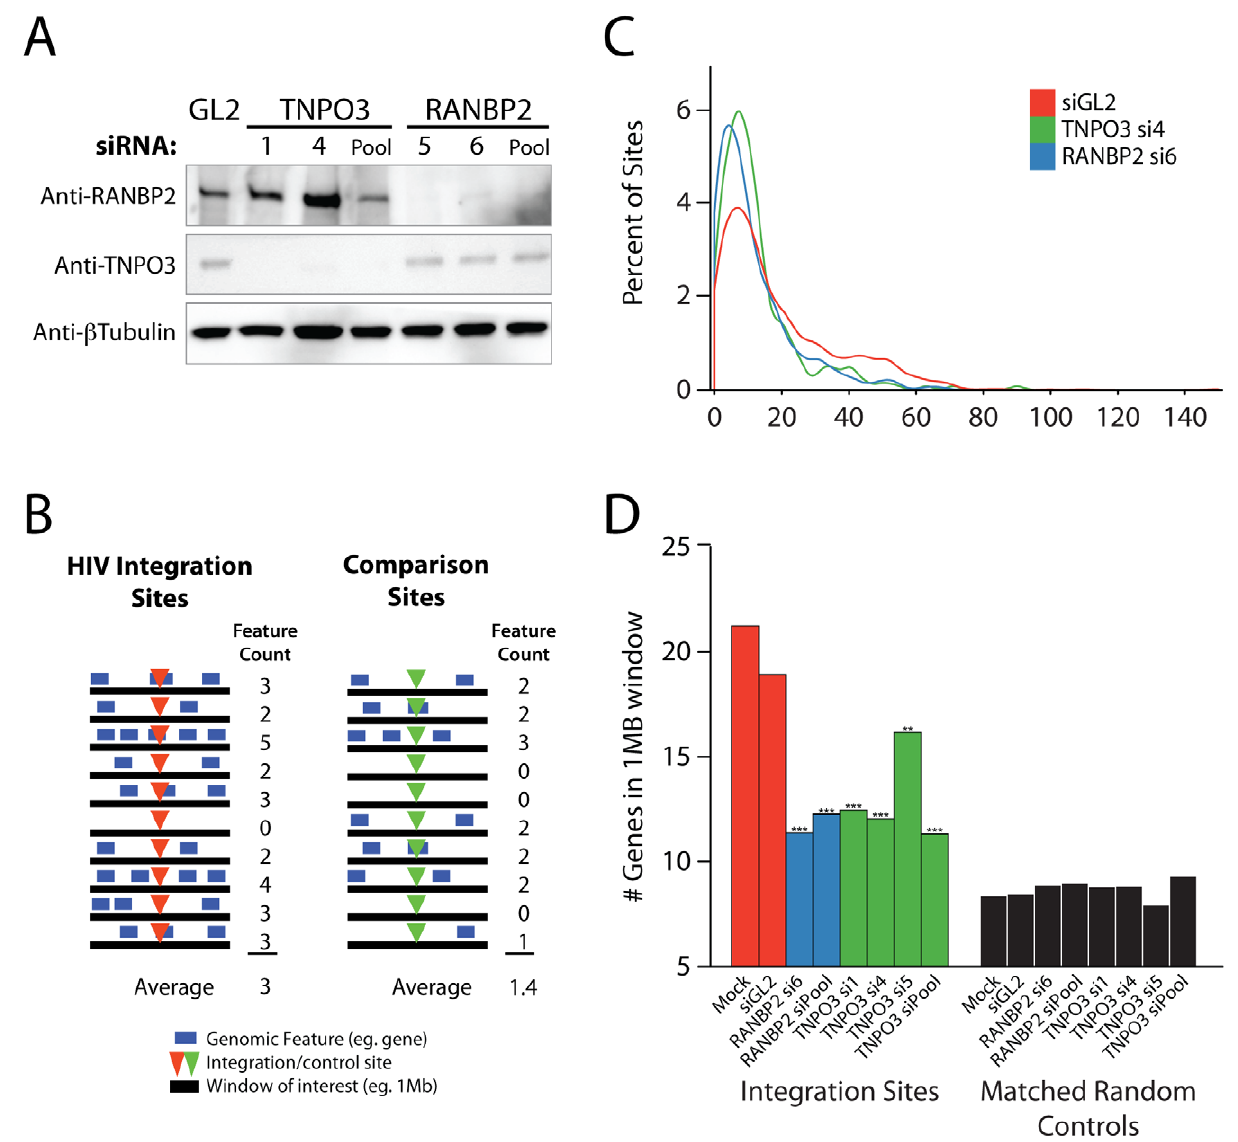
Figure 1. Effects of siRNA treatments on HIV integration in gene dense regions. Cells were transfected with individual siRNAs or an siRNA pool of four siRNAs targeting the same gene as indicated, and infected 48 hr later for an additional period of 48 hr prior to integration site analysis. (A) Reduction in Transportin-3 and RanBP2 protein levels after RNAi. Protein abundance was measured at the time of infection by Western blot with b -tubulin as a loading control. For comparison, protein levels are shown in cells treated with an siRNA against firefly luciferase (GL2), a gene not found in HEK-293T cells. (B) Overview of the approach for integration site analysis. The number of genomic features of interest (blue bars), such as transcription units, is tabulated within genomic intervals (black bars) surrounding integration sites (red arrowheads) or computationally-generated matched random control sites (green arrowheads). The average number of times the genomic feature occurs within that window can be compared across datasets. (C) Histogram indicating distribution of integration sites with respect to gene density. Cells were transfected with individual siRNAs and infected as above. Sample names in legend indicate the gene targeted followed by the individual siRNA number. The number of genes in 1 Mb windows surrounding each integration site was counted as in 1B. Integration sites in each dataset were binned (along the X-axis) according to the number of genes within 1 MB interval surrounding each site. Curves were computed from histogram plot using Gaussian kernal density estimates. (D) Barplot of the average number of RefSeq genes in 1 Mb windows surrounding sites of HIV integration or computationally generated matched random controls. Mock transfected cells (no RNAi) and cells treated with the siRNA targeting luciferase GL2 (siGL2) are shown as controls. Asterisks denote significant difference from control GL2 siRNA treated cells as determined by the nonparametric Mann–Whitney test (*P , 0.05; **P , 0.01; ***P , 0.001). tionally generated and are shown in black (described in [14,18] regions is promoted in part by RanBP2 and Transportin-3. As a and Text S1). The average gene density at integration sites in the control for the fact the knockdowns diminished infection, we RANBP2 and TNPO3 knockdown cells was reduced compared to investigated whether infections at low MOI altered the distribution cells treated with siGL2, though it remained higher than would be of integration sites, but MOI was not found to affect integration expected for random integration. Thus integration in gene dense targeting detectably (data not shown).